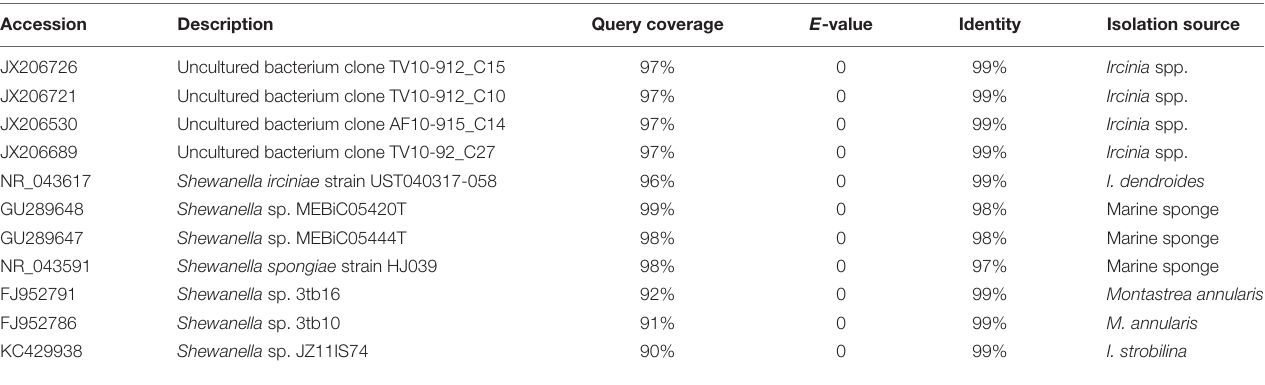
TABLE 1 | Best BLAST hit identities of the queried 16S rRNA gene of Shewanella sp.